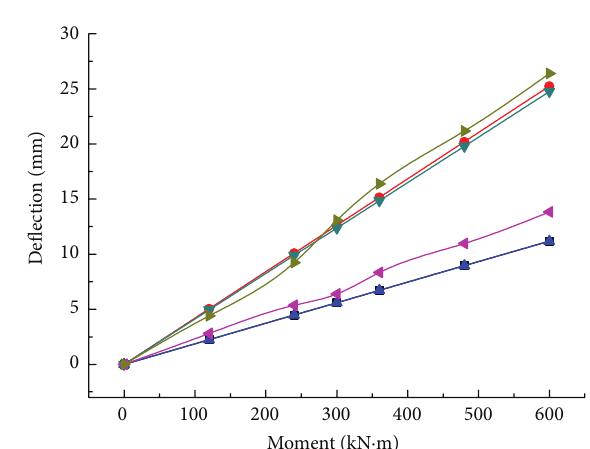
Figure 12: Deflection of Side-B with GFRP-steel combined truss.